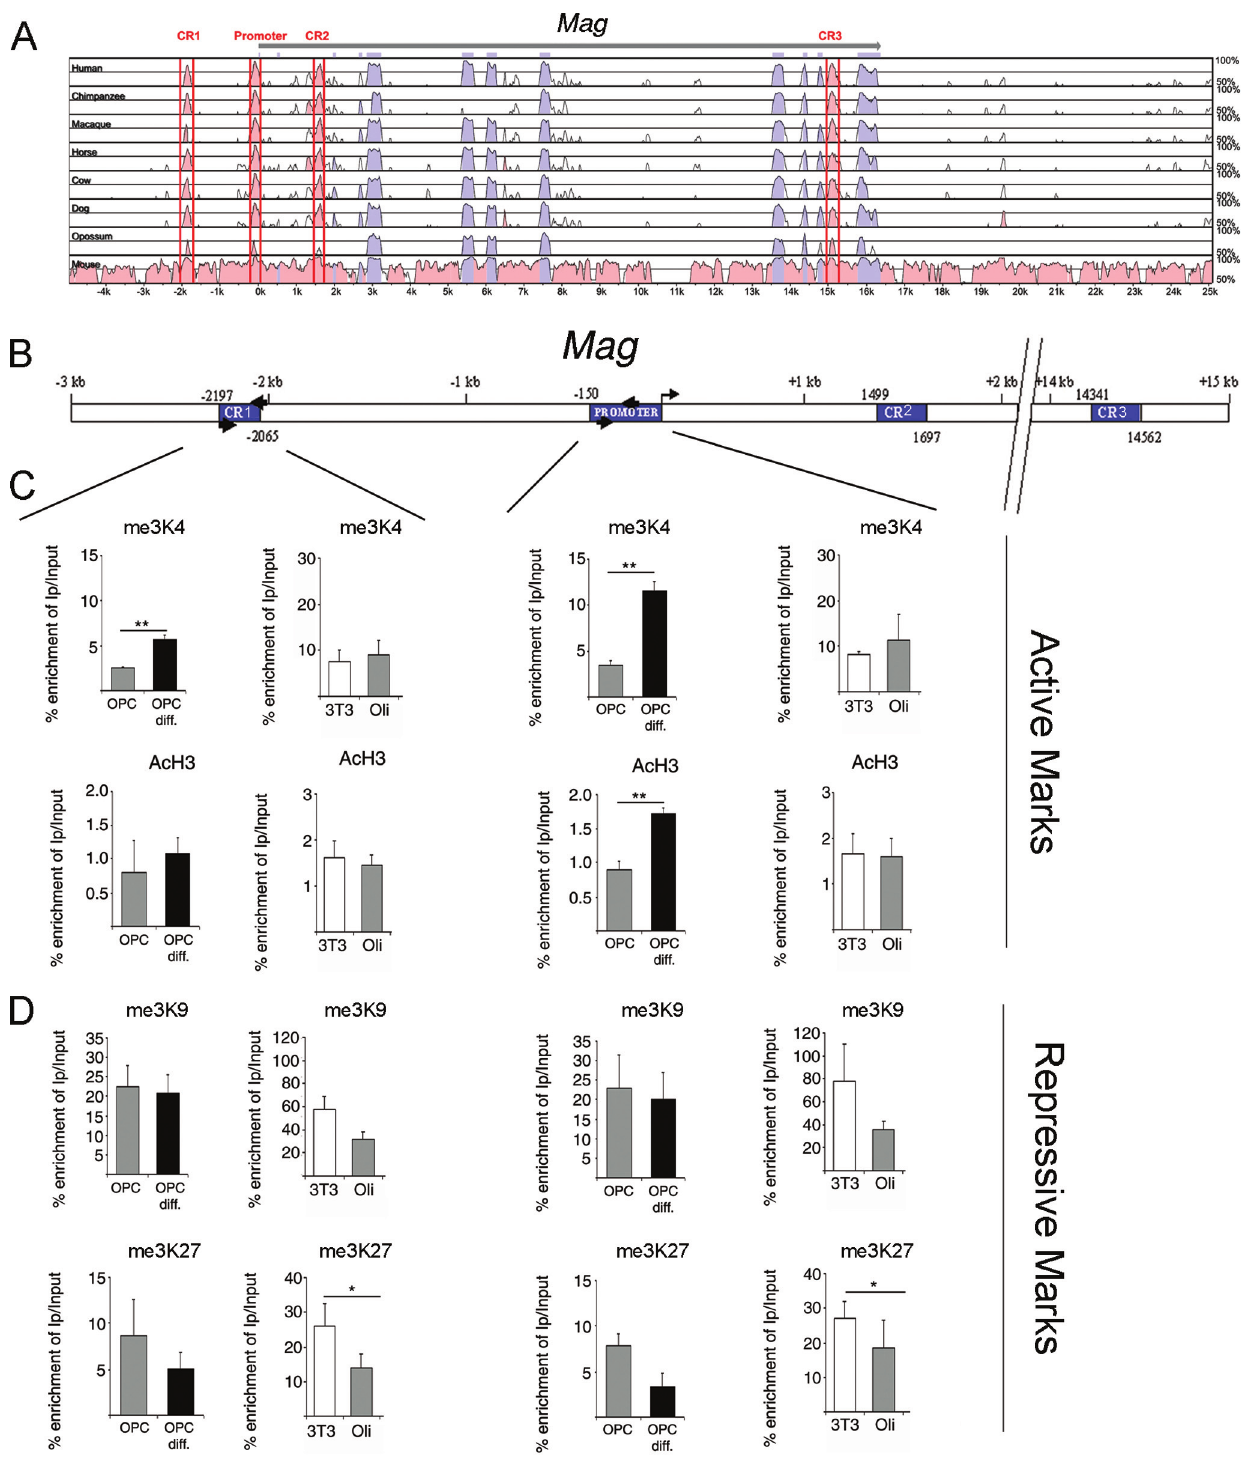
Figure 3. Comparison of the chromatin regions at the Mag gene between oligodendrocyte progenitors and fibroblasts. Comparative sequence analysis of conserved (pink) and transcribed regions (blue) of the Mag promoter in different animal species (A). B, Schematic representation of conserved and/or previously reported regulatory regions of the Mag promoter. Schematic representation of conserved regulatory regions (blue boxes) of the Mag promoter (B). Comparative ChIP analysis of samples isolated from NIH3T3, Oli neu cells (Oli), proliferating (OPC) and differentiating (OPC diff) oligodendrocyte progenitors (C). Histone modifications in the different Mag promoter regions were assessed by chromatin immunoprecipitation using antibodies specific for the active histone marks me3K4H3 and AcH3(C) and for the repressive histone modifications me3K9H3 and me3K27H3 (D). The chromatin regions of the Mag gene were characterized by permissive histone marks in oligodendrocyte progenitors and non-permissive marks in fibroblasts. ChIP was performed on five separate cultures. Results are expressed as mean 6 standard deviation (SD) and statistically analyzed using two tailed Student’s t tests. (*p , 0.05, **p , 0.01).